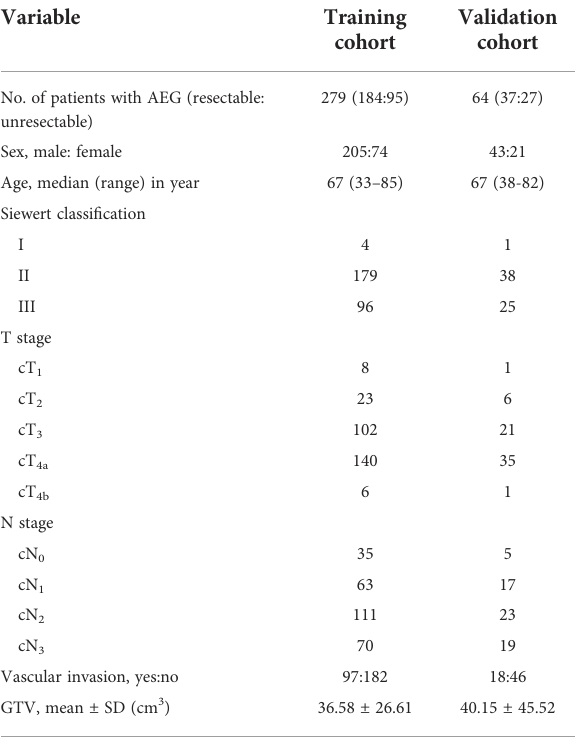
TABLE 1 Demographic and clinical information of all enrolled patients. Variable